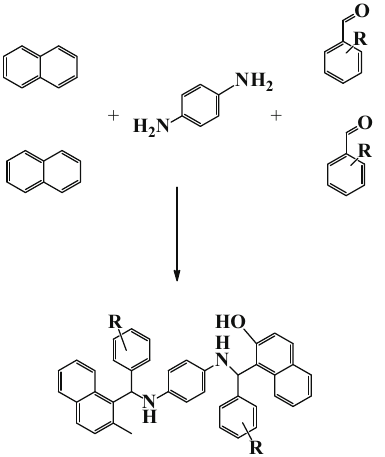
Figure 8: Synthesis of bis - Betti